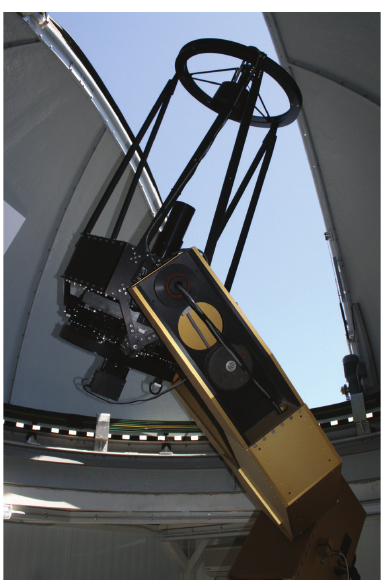
Figure 6: Complete view of the 0.5 m telescope inside the 3.5 m dome in Calar Alto Observatory.